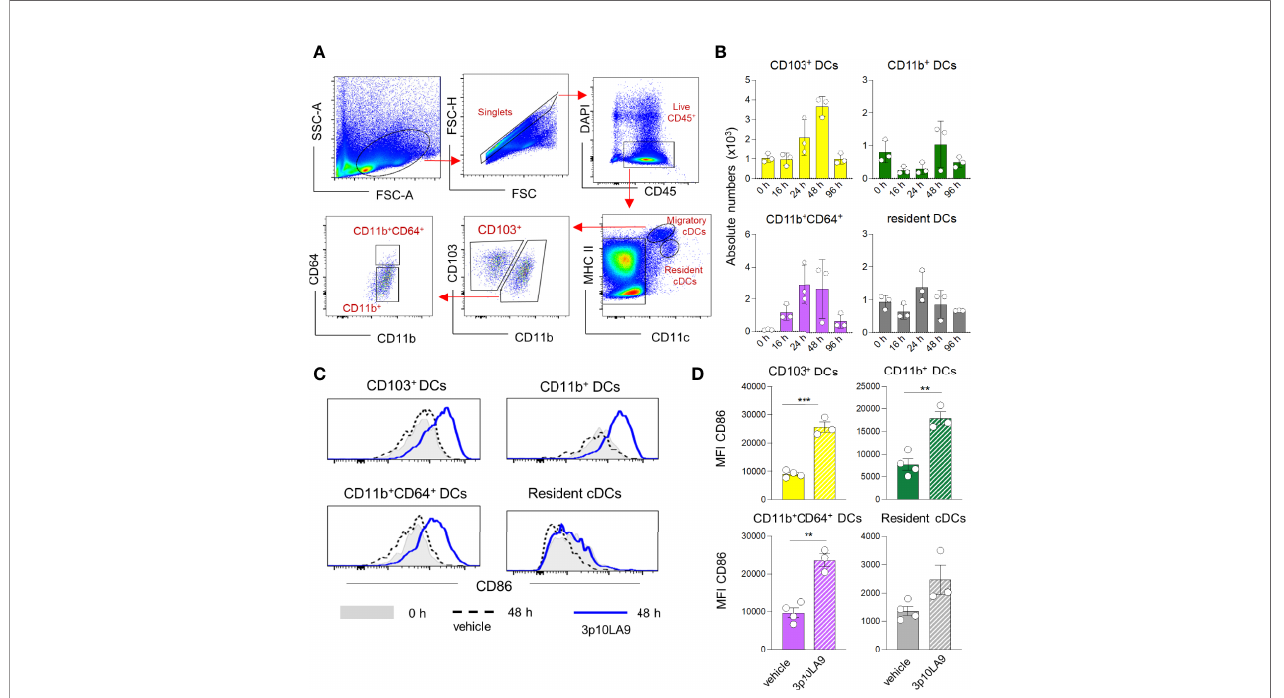
FIGURE 7 | Increased numbers of migratory DC in LN of intranasally treated mice. (A) Representative fl ow cytometry dot plots showing the gating strategy for distinct resident MHCII + CD11c ++ and migratory MHCII ++ CD11c + DC subpopulations (CD103 + DCs, CD11b + DCs, CD11b + CD64 + DCs). (B) Intranasal treatment protocol and time points of LN collection as described in Figure 4B . Absolute numbers of LN CD103 + DCs, CD11b + DCs, CD11b + CD64 + DCs at 0h, 16h, 24h, 48h and 96 h post intranasal 3p10LA9 inoculation. The error bars represent the SEM (n= 3 mice). Some of the timepoints (0h, 24 and 48 h) have been con fi rmed by two independent experiments. (C) Representative fl ow cytometry histogram showing the expression levels of the costimulatory molecule CD86 on LN CD103 + DCs, CD11b + DCs, CD11b + CD64 + DCs and resident DCs. Mice were intranasally inoculated and LN collected 48 h later. Grey shaded histogram: untreated; dash line histogram: vehicle alone; blue line histogram: 3p10LA9. (D) Bar chart representing the mean of fl uorescence intensity of CD86 on LN CD103 + DCs, CD11b + DCs, CD11b + CD64 + DCs and resident DCs from inoculated WT mice (vehicle alone and 3p10LA9). The error bars represent the SEM (n= 3 mice). **P < 0.01; ***P < 0.01; two-tailed t-Student ’ s